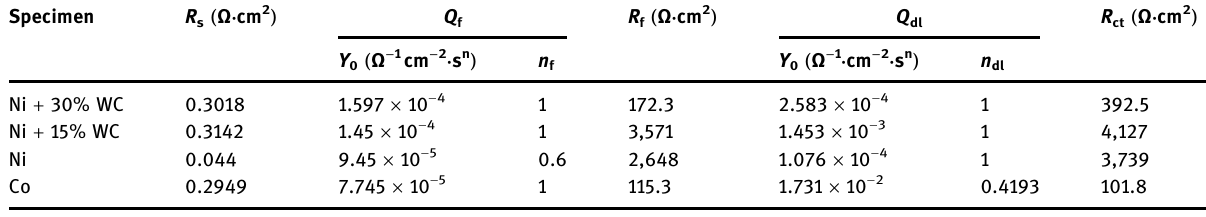
Table 8: Impedance fi tting results of coatings in 3.5 wt% NaCl solution for 120 h Specimen